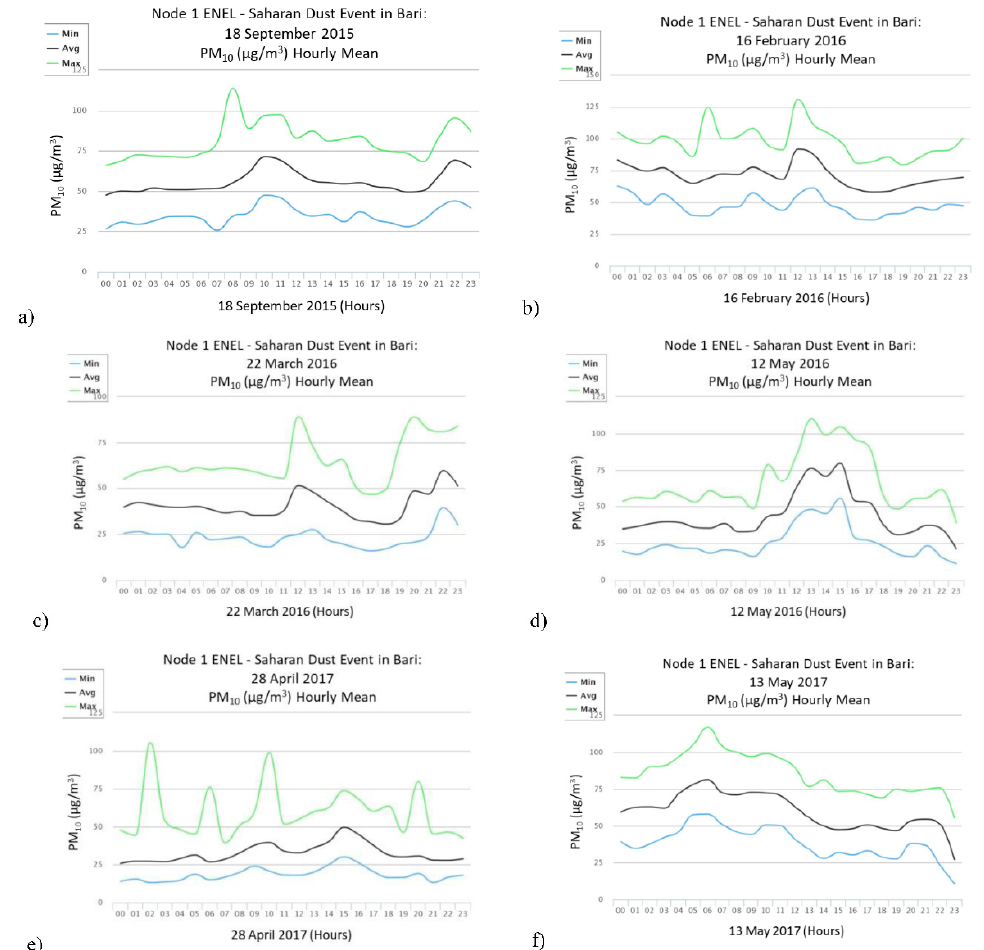
Figure 3. PM 10 hourly mean ( μ g/m 3 ) time-series of the sensor node (Node 1), installed on the roof of the ENEL building (Longitude East: 16.87370 and Latitude Nord: 41.11720), close to a street with daily busy traffic in Bari: ( a ) 18 September 2015; ( b ) 16 February 2016; ( c ) 22 March 2016; ( d ) 12 May